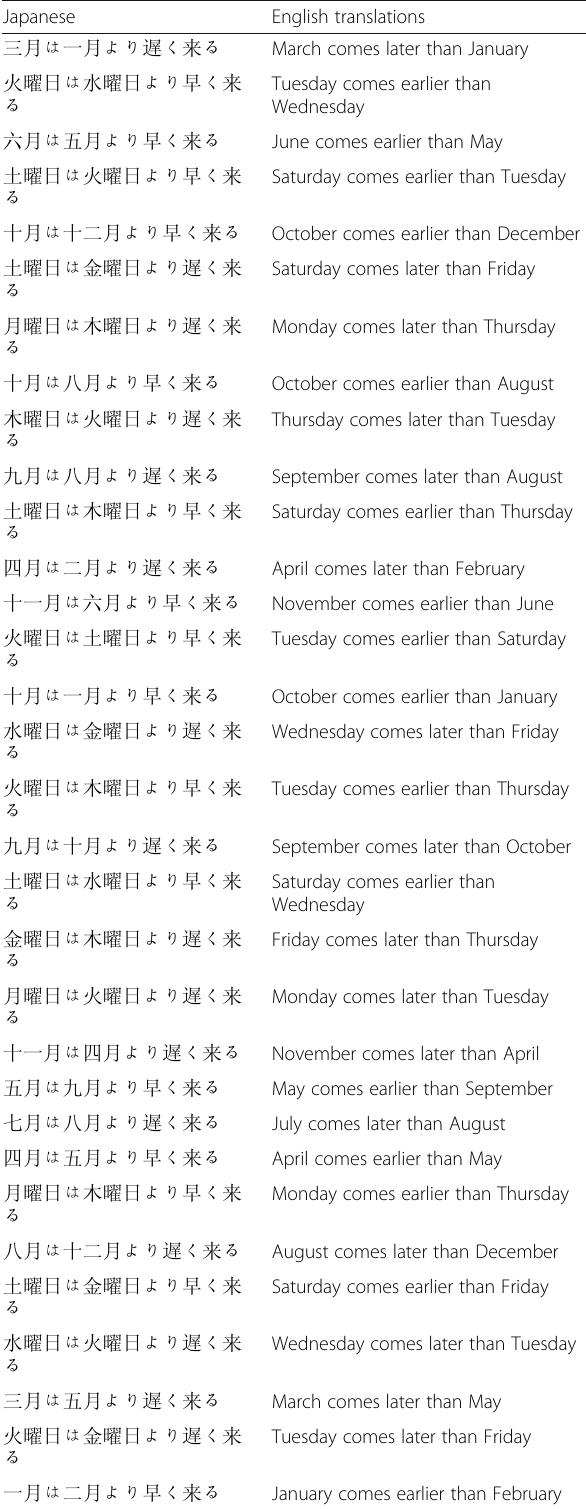
Table 1 The left column contains the original Japanese sentences and the right column their English